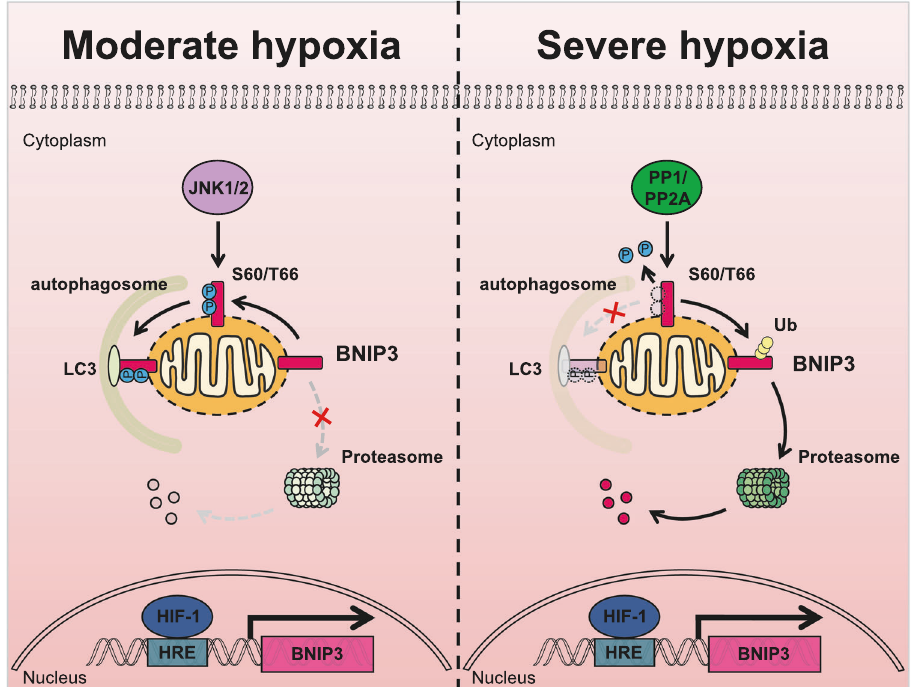
Fig. 7 The hypothetical mechanism of BNIP3 phosphorylation-mediated mitophagy under hypoxia. In response to moderate hypoxia (10%